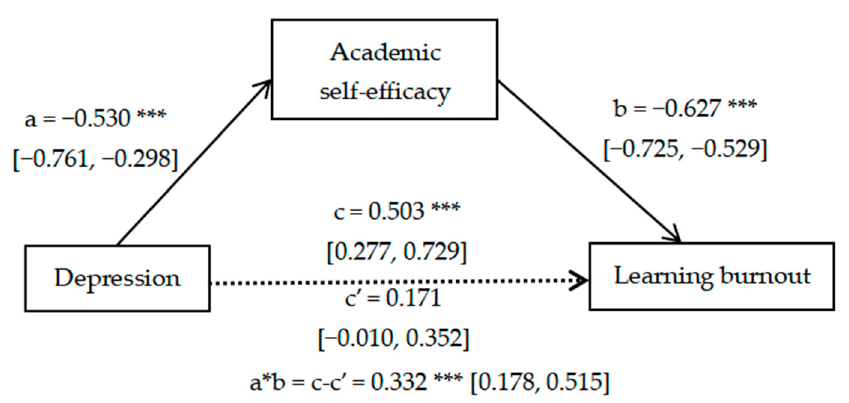
Figure 2. Mediating effect of academic self-efficacy on depression and learning burnout. *** p -value <